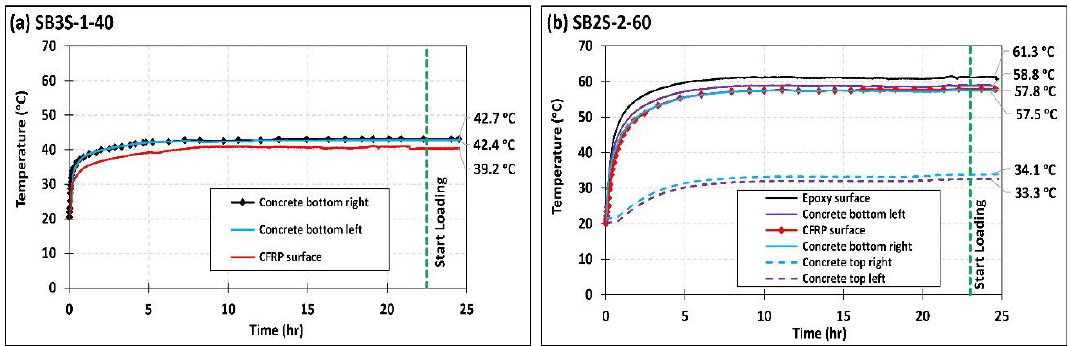
Figure 2. Evolution of temperature with time at different locations of specimens ( a ) SB3S-1-40 and ( b ) SB2S-2-60 (before and during loading).